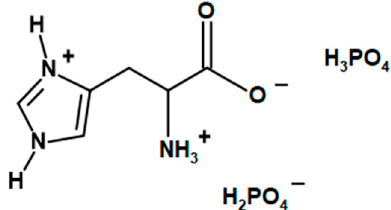
Figure 12. The chemical structure of L-histidinium dihydrogen phosphate-phosphoric acid (LHP). Firstly, LHP (10 wt. %, 20 wt. % or 30 wt. %) was added to the resin and stirred using